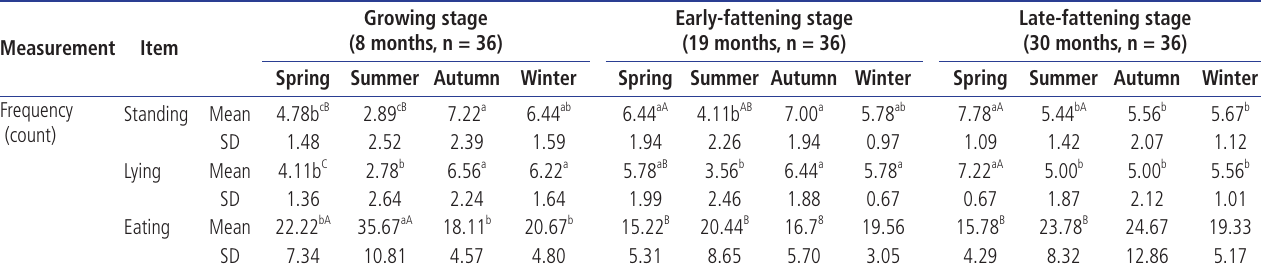
Table 5. Behavioral changes in bout frequency of standing, lying, and eating of Hanwoo steers (n = 108) Measurement